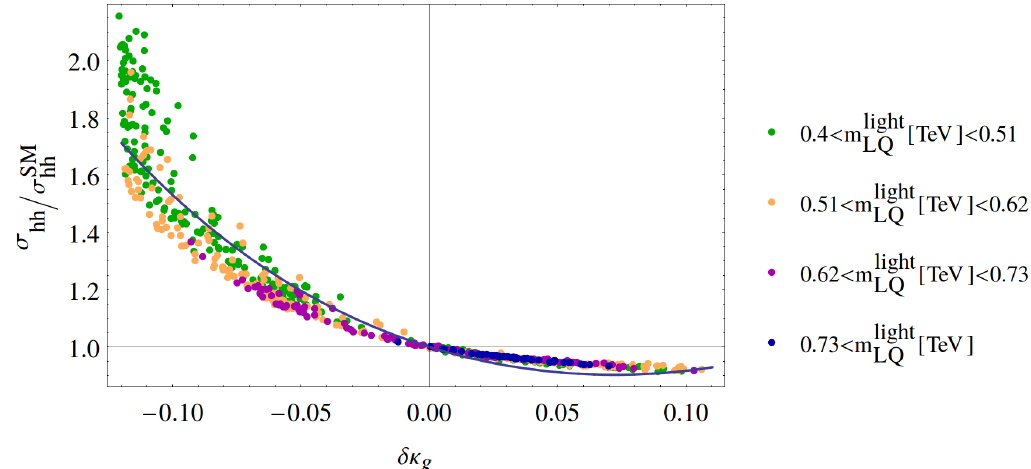
Figure 10. LO σ hh normalized with respect to the SM one, as function of δκ g , in color values of the lightest LQ mass m light . The blue line corresponds to the LET LQ